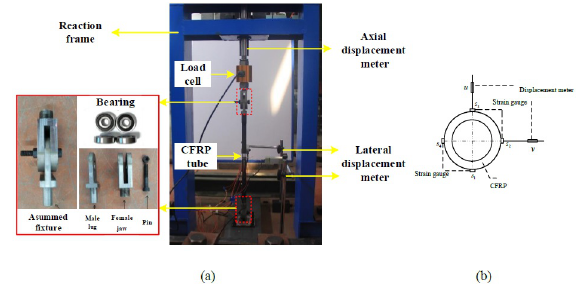
Figure 3: Long tube compression test (a) set-up details, (b) strain gauge and displacement meter